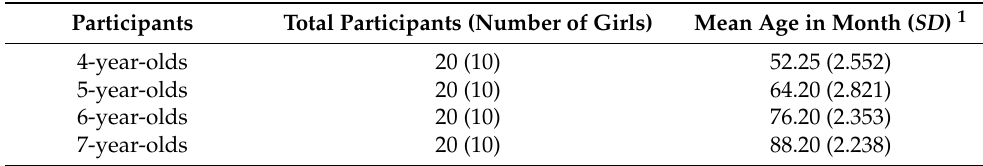
Table 2. Demographics of the participants in the current study.